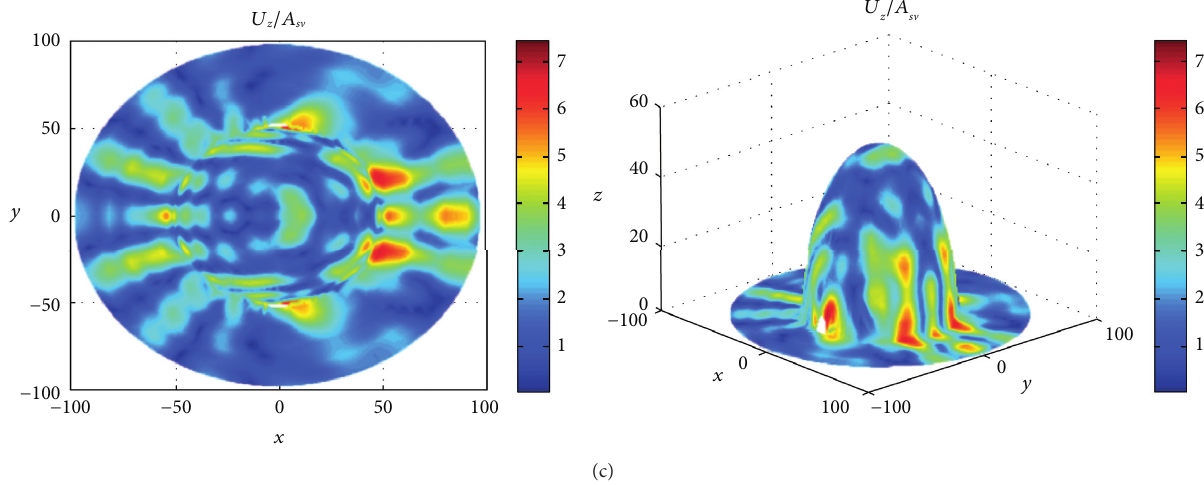
Figure 18: Surface displacement amplitude of the 3D tunnel mountain under the incident SV wave ( η � 5 . 0 , α � 30 ° ): (a) surface dis- placement amplitude in x direction; (b) surface displacement amplitude in y direction; (c) surface displacement amplitude in z